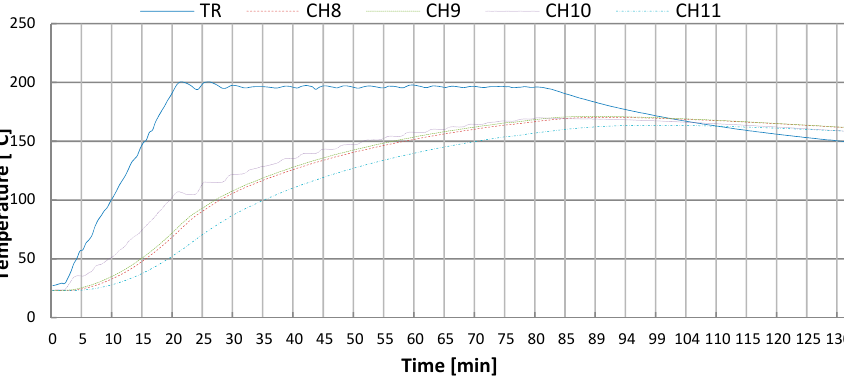
Figure 10. Temperature distribution in pilot sample of C-2.5. Heating curve to 200 ◦ C.